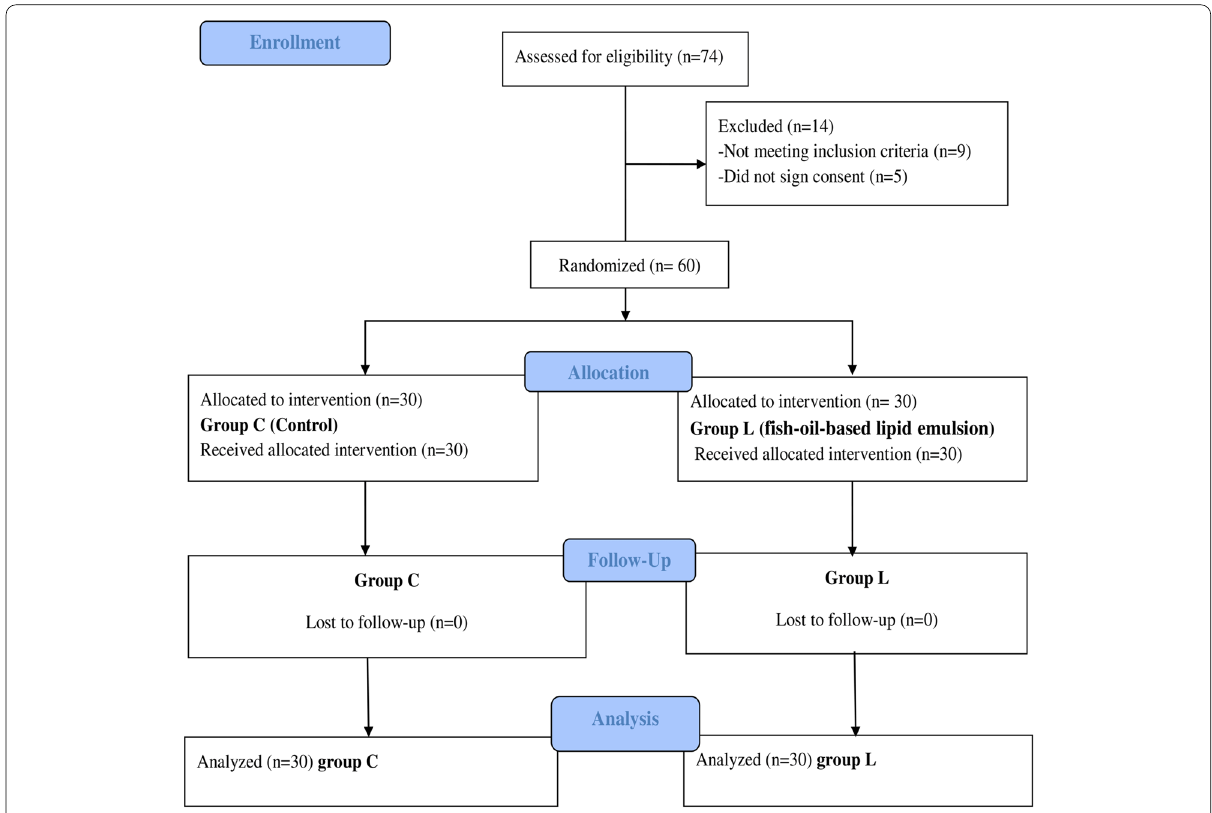
Fig. 2 CONSORT Flow Chart between the study